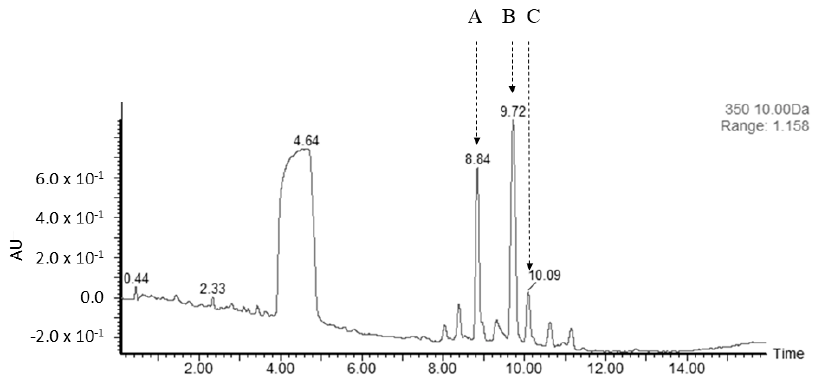
Figure 3. Activation of the manumycin-type BGC by the heterologous expression, UHPLC record. Three novel metabolites were produced in K4-114 × 1T2 and detected at λ = 350 nm: A: ES-: 507.2173, C 28 H 32 N 2 O 7 , B: ES-: 521.2343, C 29 H 34 N 2 O 7 , C: ES-: 533.2308, C 30 H 34 N 2 O 7 .